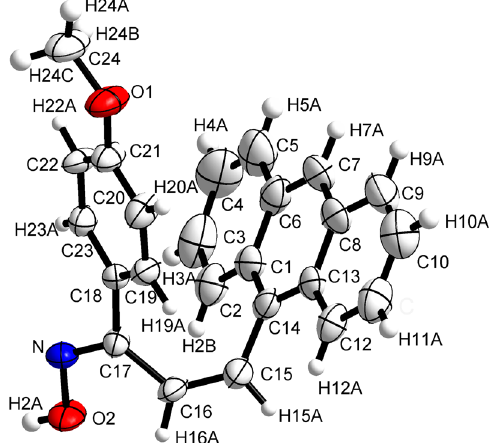
Table  : Data collection and